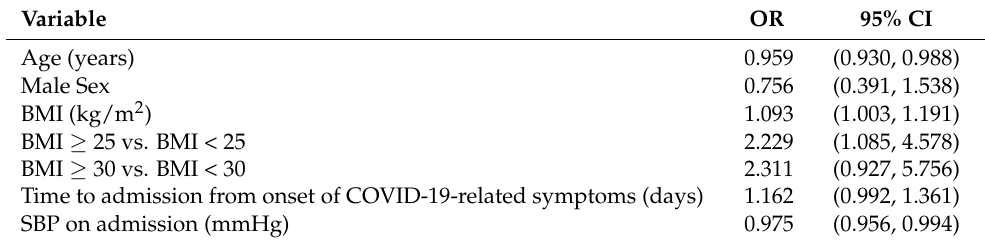
Figure 1. Kendall Tau correlations of glucose control status and inflammatory markers with d-dimer. FBS, fasting blood sugar; GA, glycated albumin; CRP, C-reactive protein. Table 3. Unadjusted logistic regression.